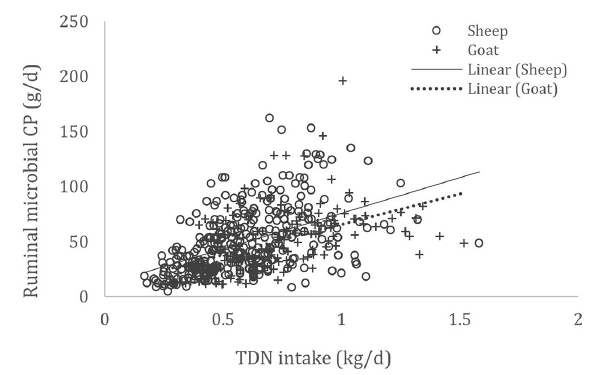
FIGURE 2 | Total databank used to establish the relationship between digestible organic matter (dOM) intake (kg/day) and microbial crude protein (MCP—g/day) produced in the rumen of sheep and goats, made from 18 experiments ( n =